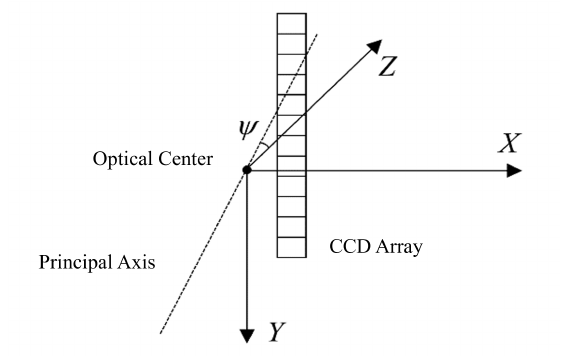
Figure 1. Line array camera coordinate